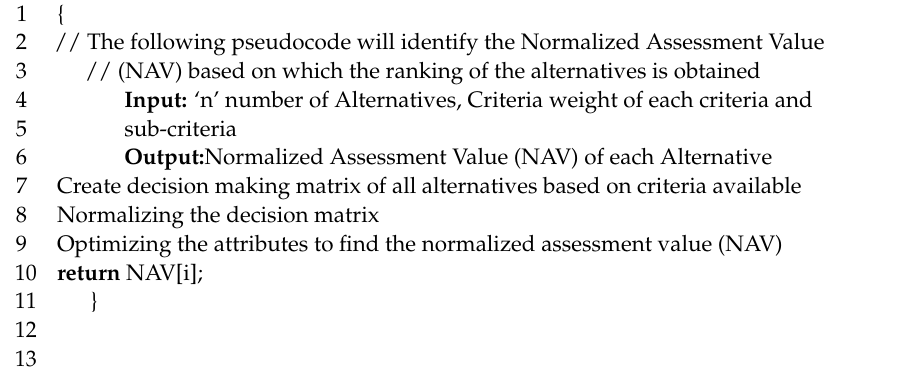
Algorithm 4: MOORA (cr_weight[m], n)// MOORA